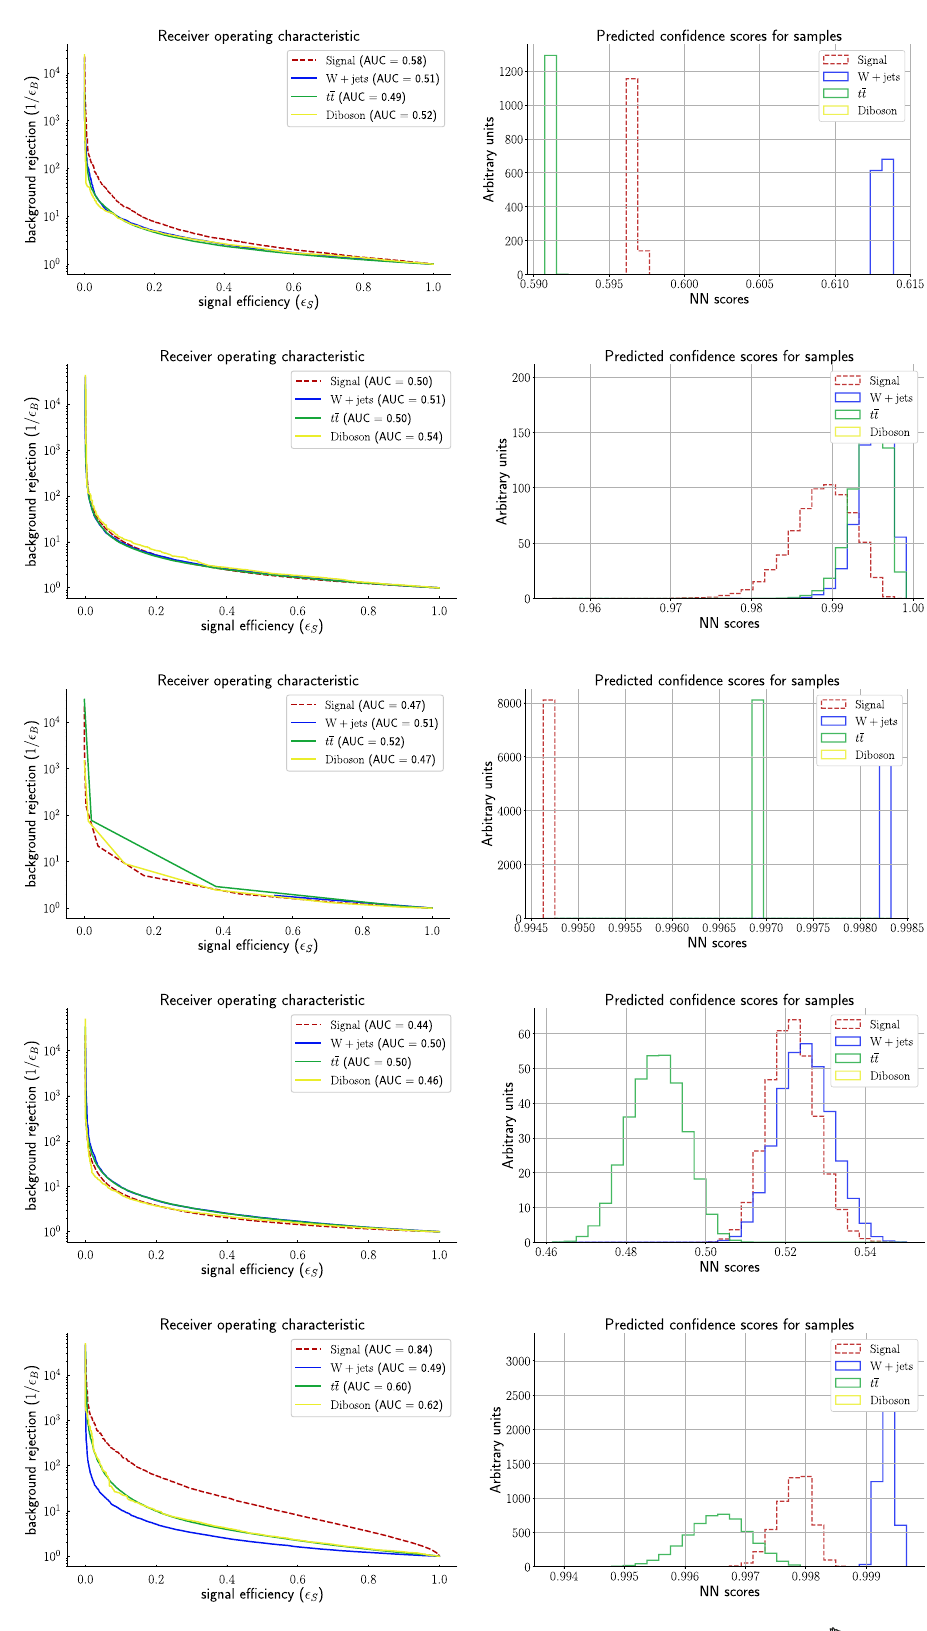
Fig. 12 Receiver operator characteristic (ROC) plots for the neural networks of the doublet VLLs from the masses of 100 GeV (top) to 500 GeV